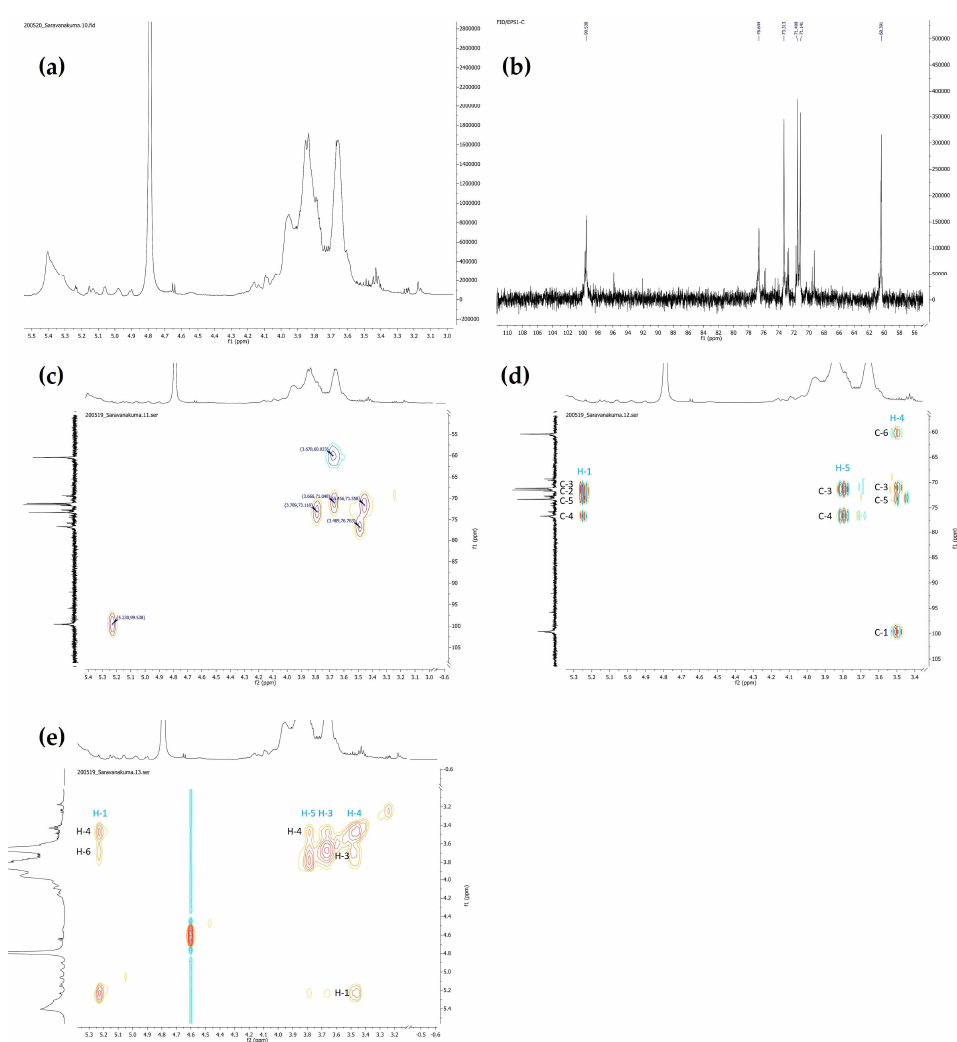
Figure 3. Structural characterization of EPS1 by NMR spectral analysis: 1 H NMR spectrum ( a ), 13C NMR spectrum ( b ), HSQC spectrum ( c ), HMBC spectrum ( d ), and NOESY NMR spectrum ( e ). For better readability, refer to the Supplementary Materials (Supplementary Figure